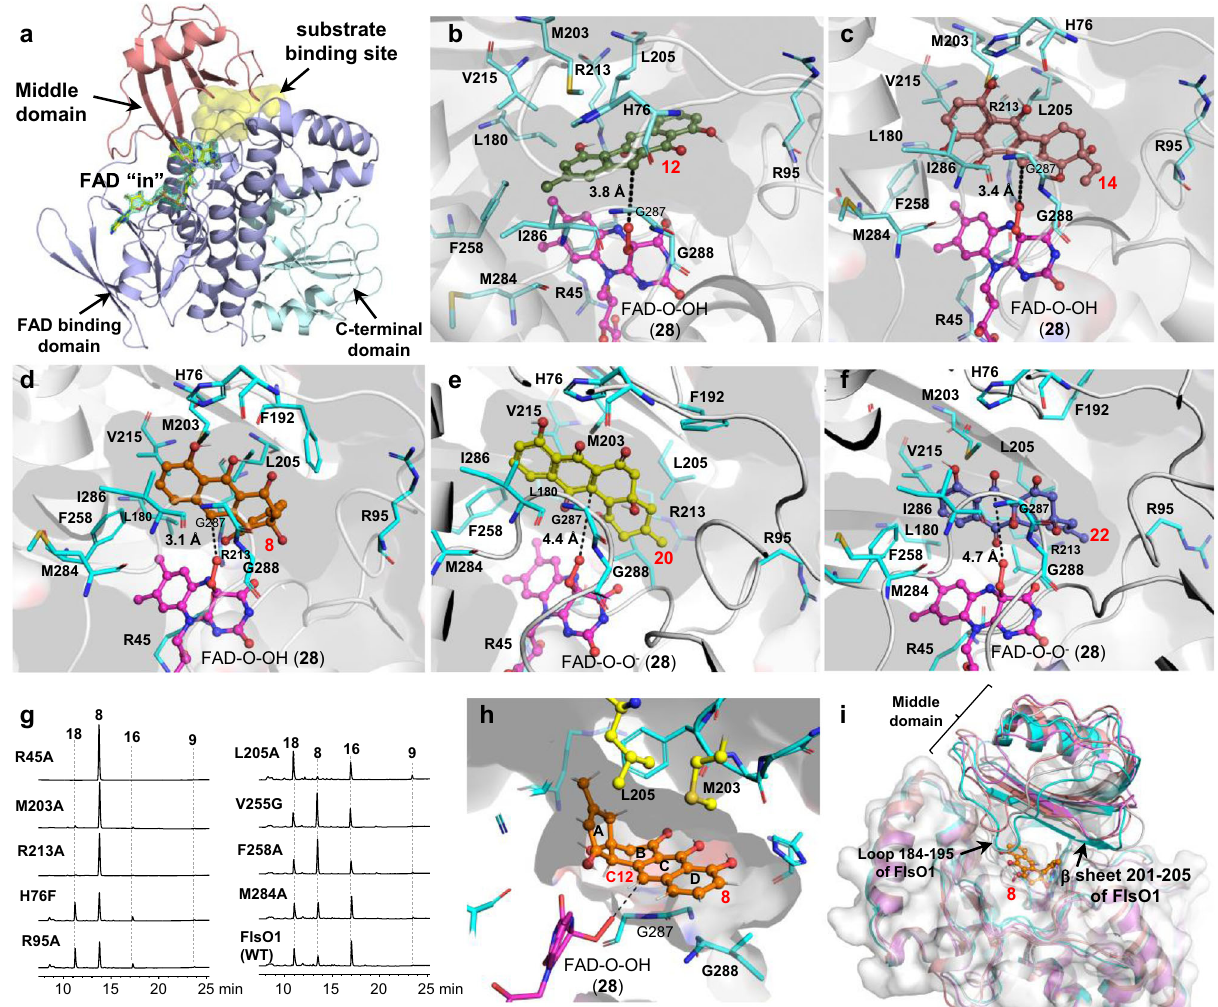
Fig. 5 | Structural analysis of FlsO1. a Crystal structure of FlsO1 in complex with FAD.The2 F O - F C map(contouredat2.5 σ )ofFADisshownasgreenmesh.Notethat FAD adopt an “ in ” conformation. The substrate binding pocket predicted by POCASA is shown in yellow surface. Predicted binding modes of ( b ) the native substrate benzo fl uorene ( 12 ); c NEN C ( 14 ); d PJM ( 8 ); and the two proposed intermediates ( e ) 20 and ( f ) 22 . The compounds are shown as colored sticks and spheres for 12 (smudge), 14 (salmon), 8 (orange), 20 (yellow) and 22 (lightblue), respectively. Notably, the intermediate 22 adopts similar orientation as 8 and 20 ,